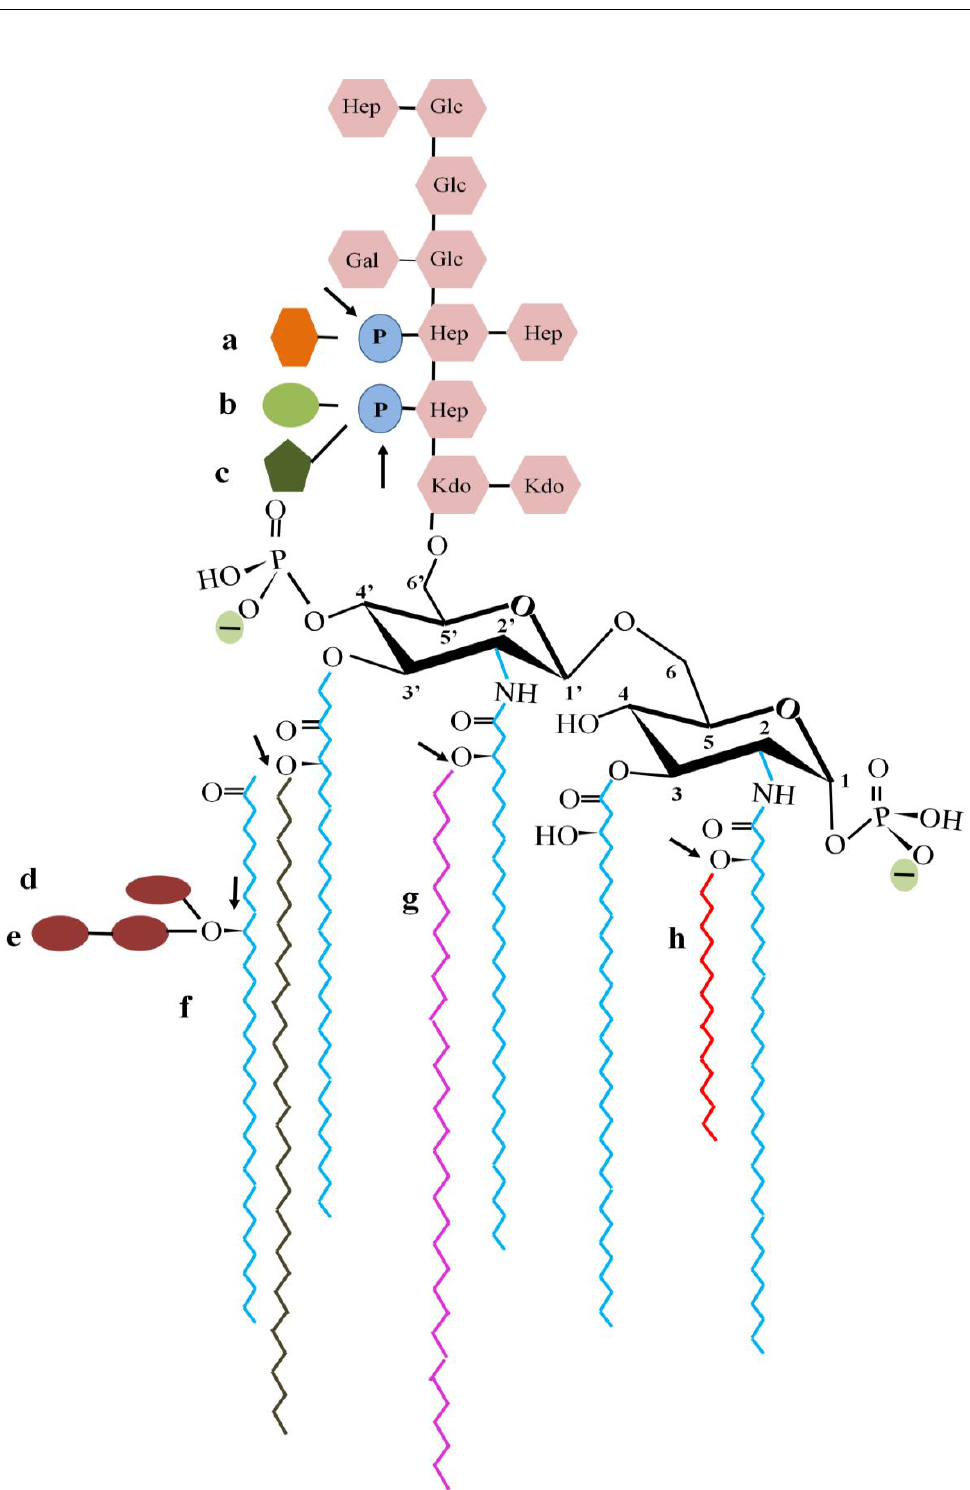
Figure 2. Lipid A modification in Gram-negative bacteria leading to altered membrane properties.